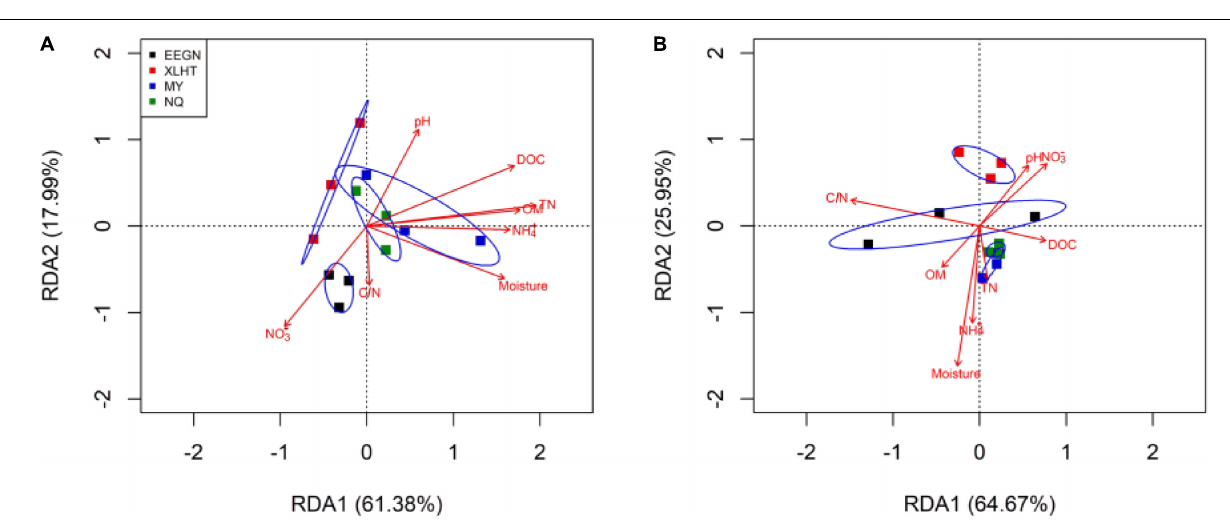
FIGURE 4 | Redundancy analysis of overall nitrogen functional genes and soil characteristics for individual samples at a soil depth of 0–10 cm (A) and 30–40 cm (B) , respectively. The site abbreviations are defined in Table 1 .